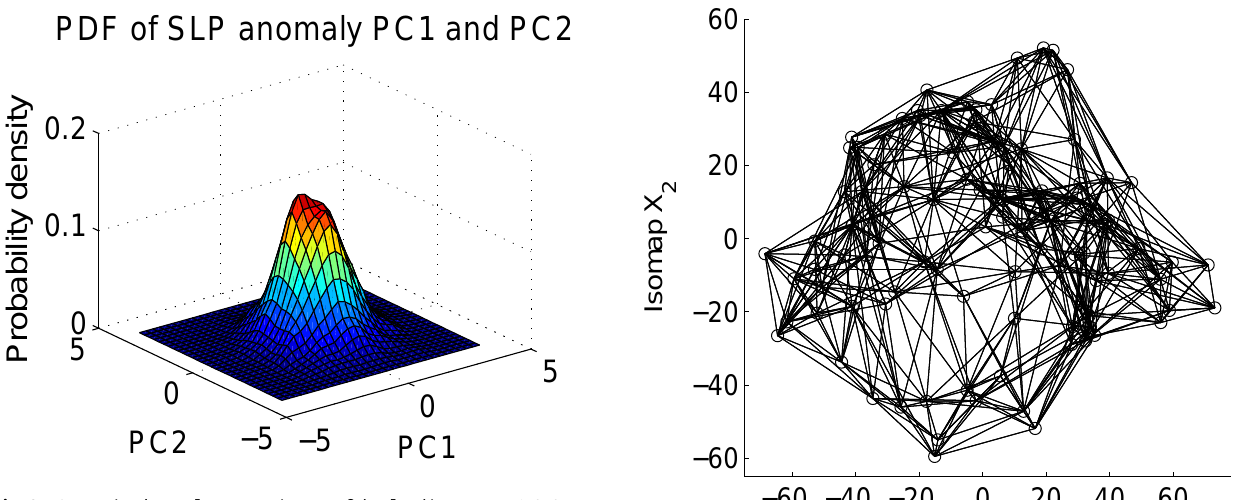
Fig. 4. Illustration showing the neighborhood graph for the first 100 anomalous SLP observations within the two-dimensional Isomap embedding space. The data have been scaled to zero-mean and unit variance. Axis units arbitrary.